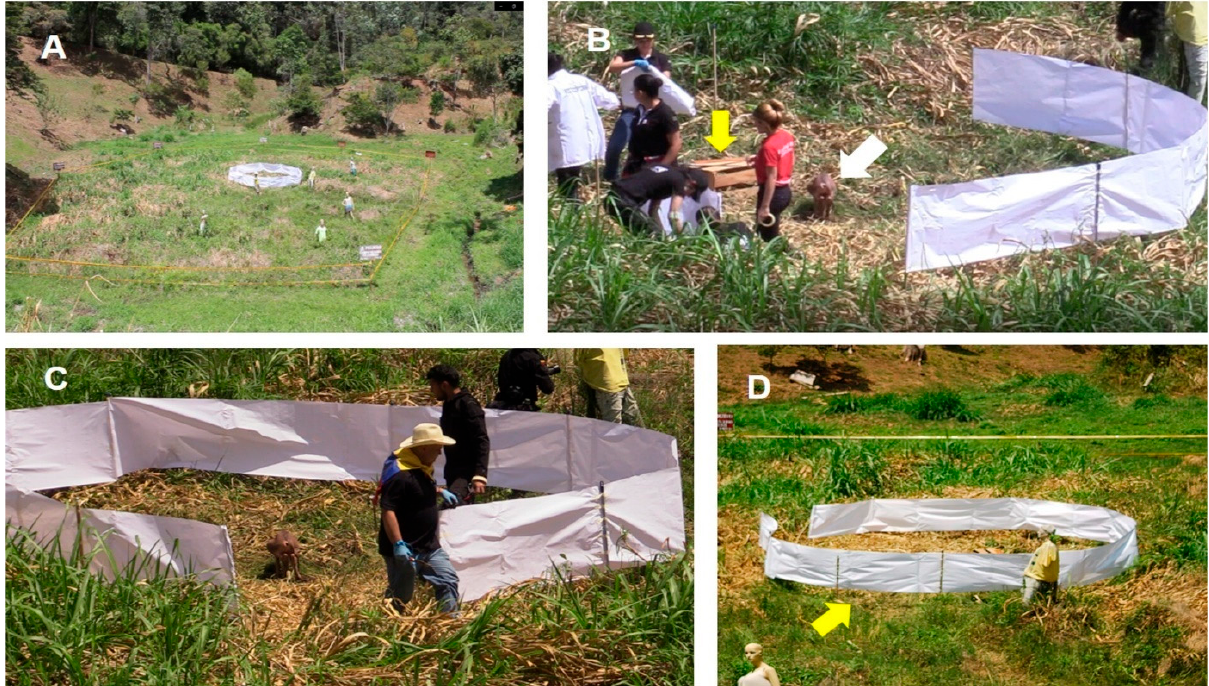
Figure 3. ( A ) Panoramic view of the experimental field bounded by a yellow tape; ( B , C ) south view; ( D ) east view. ( B ) Wooden box (yellow arrow) to the left side of the animal carcass (white arrow); ( C ) Position of part of the carcass in the center of the perimeter. Only a small portion of the fence remained open for a better view of the epicenter of the explosion; ( D ) Panoramic view of the paper fence before the explosion. Free space below the fence (yellow arrow).